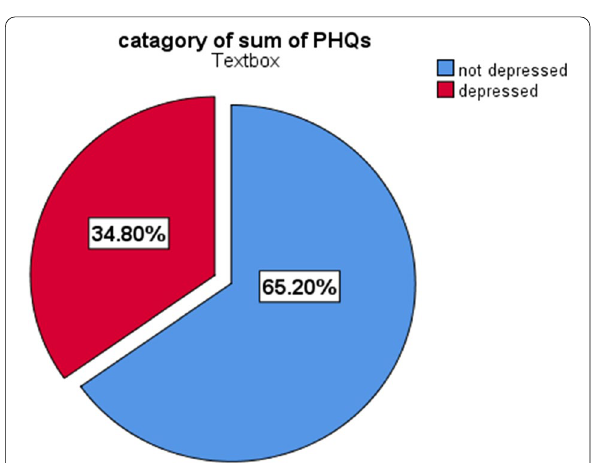
Fig. 2 Prevalence of depression among people with epilepsy (n 296) on follow-up at Ayder comprehensive specialized hospital = and Mekelle hospital, Mekelle, Tigray, Ethiopia,